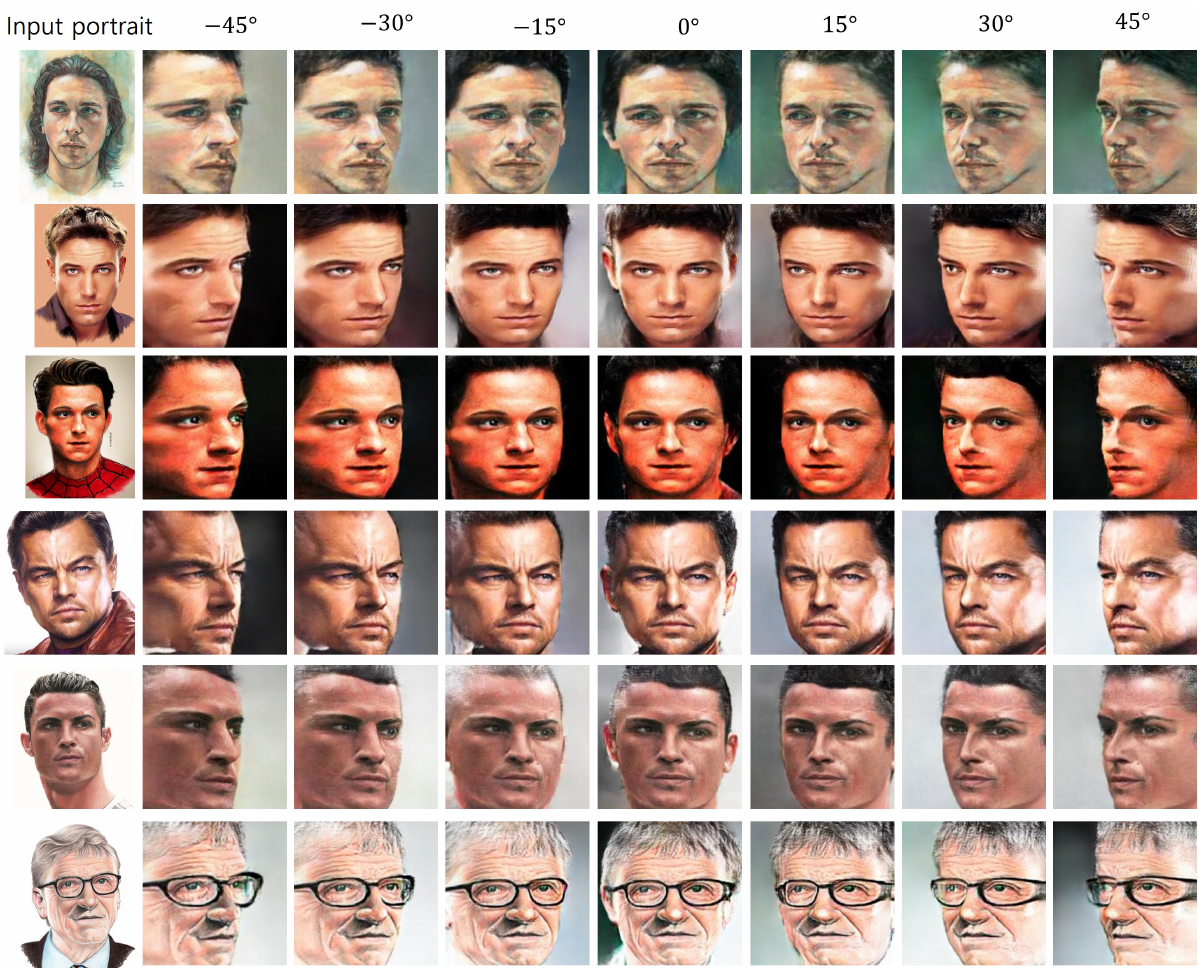
Figure 5. Male portraits from